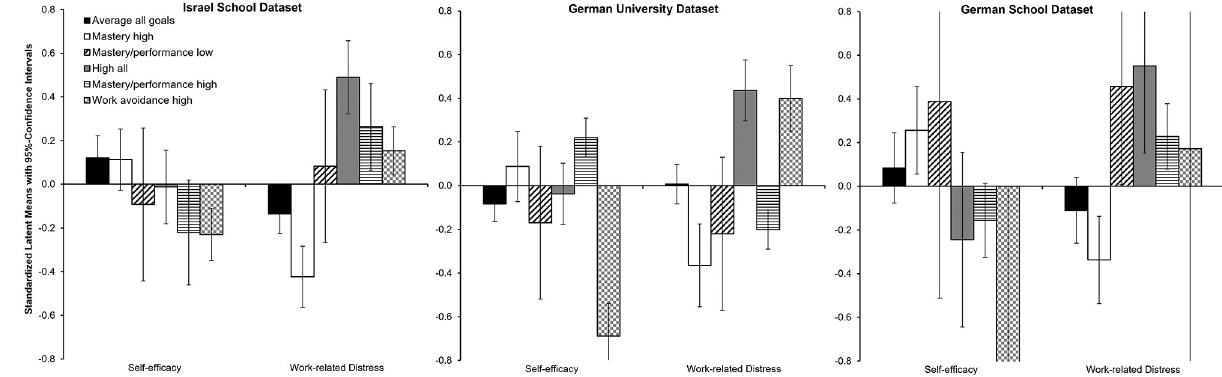
Fig 2. z -standardized latent means and 95% confidence intervals for self-efficacy and work-related distress levels in the six profiles per study set.